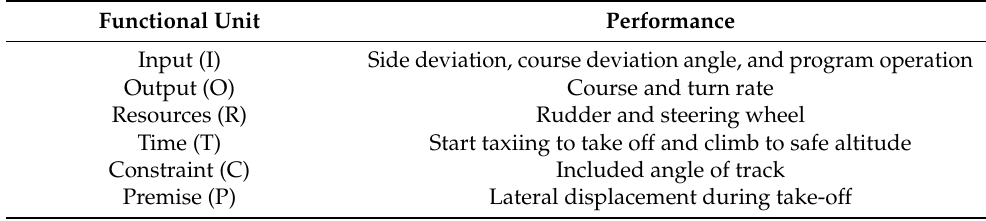
Table 4. “F4: Steering device” functional structure.